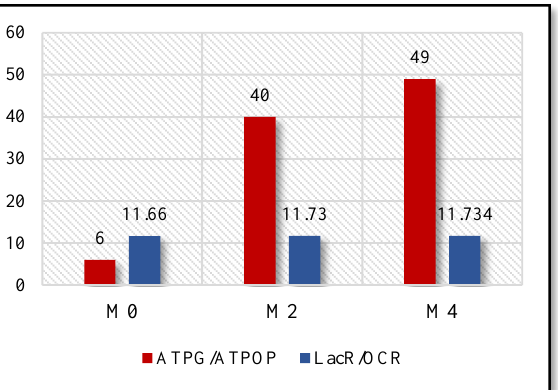
Figure 3. ATPG/ATPOP and LacR/OCR results for non-metastatic (M0) and metastatic cases (M2 and M4).